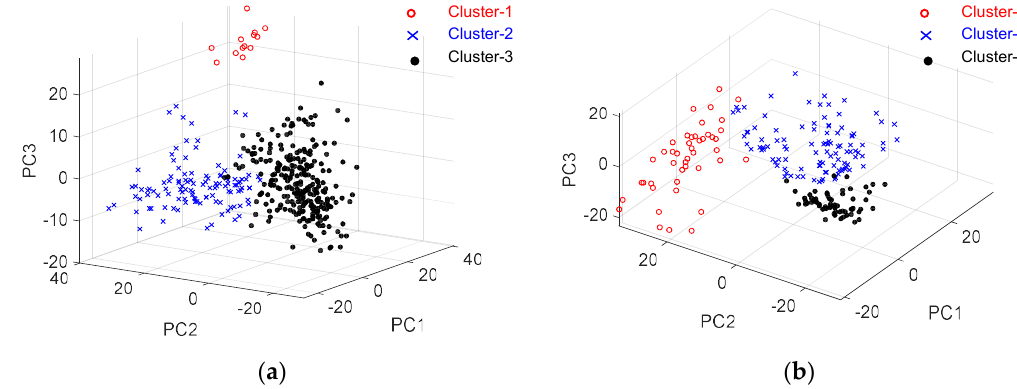
Figure 8. Clusters in principle component dimensions. ( a ) Confined specimen; ( b ) Unconfined specimen.